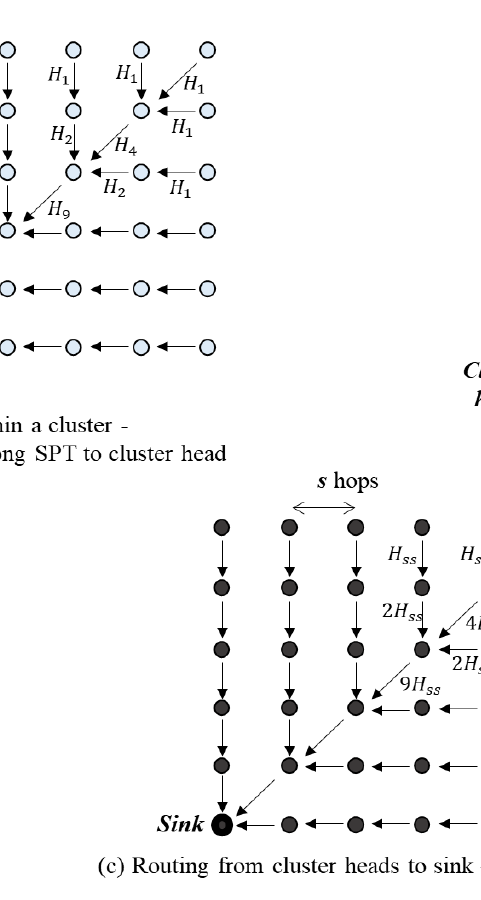
Figure 12. Routing pattern of the 2-D network in Reference [17].